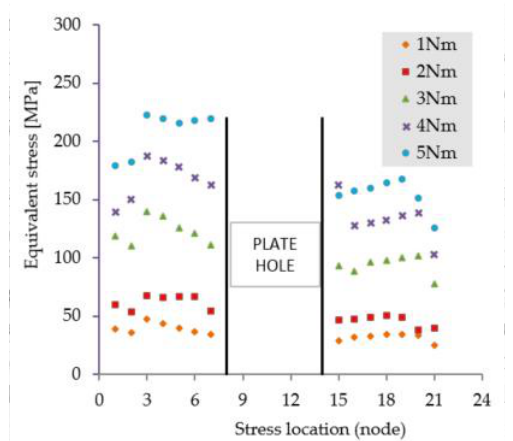
Figure 10. Stress distribution in the critical region. Scenario III.